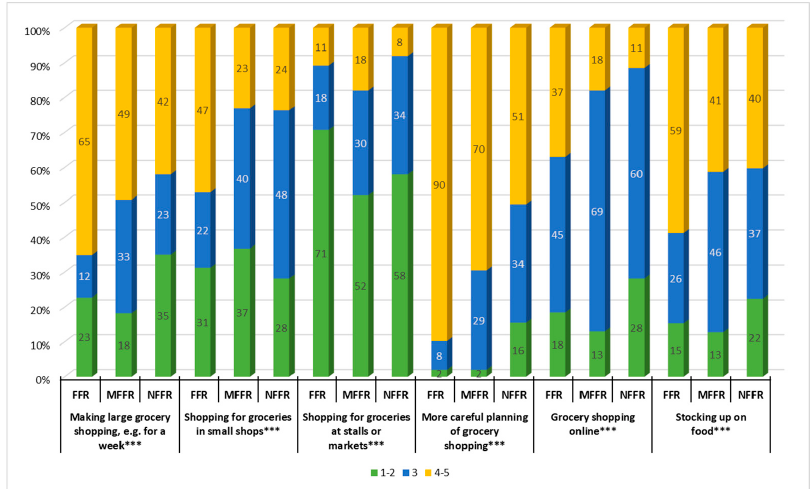
Figure 2. Changes in food purchases. FFR—Fearing and following the rules, MFFR—Moderately fearing and following the rules, NFFR—Not fearing and not following the rules. The direction of changes: 1—much less often, 2—less often, 3—no changes, 4—more often, 5—much more often. Statistically significant in the chi-square test at: *** < 0.0001